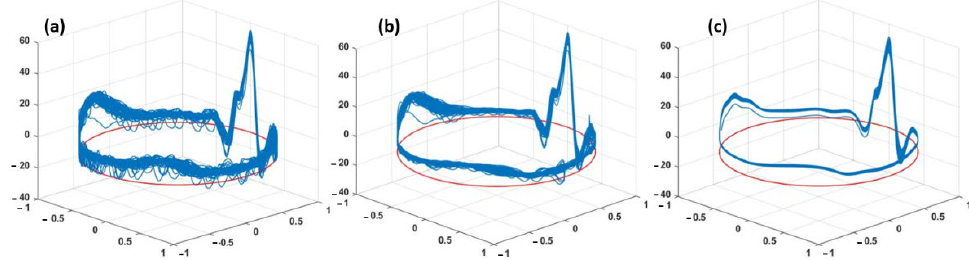
Figure 3. A phase-wrapped ECG signal of records “a01”. ( a ) Abdominal ECG (raw data); ( b ) mECG extracted using EKF; and ( c ) mECG extracted using our EnKF.